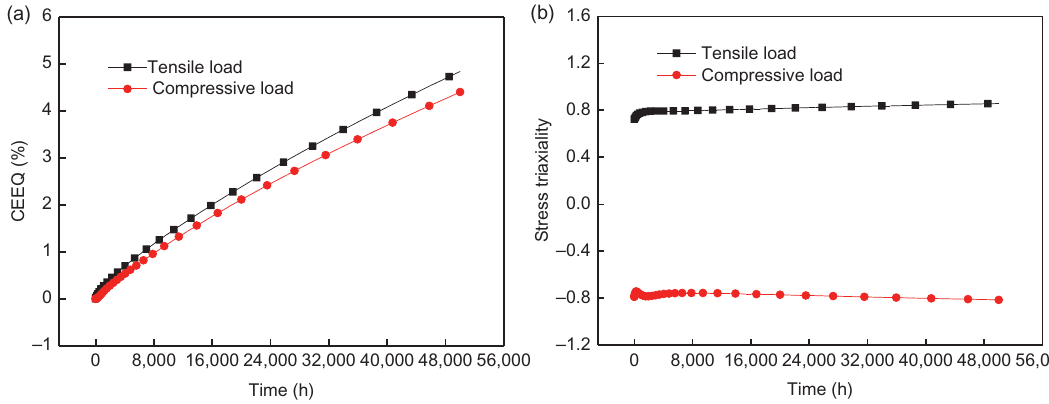
Figure 9: The maximum CEEQ (a) and stress triaxiality (b) change with time at the fillet for tensile and compressive loads.